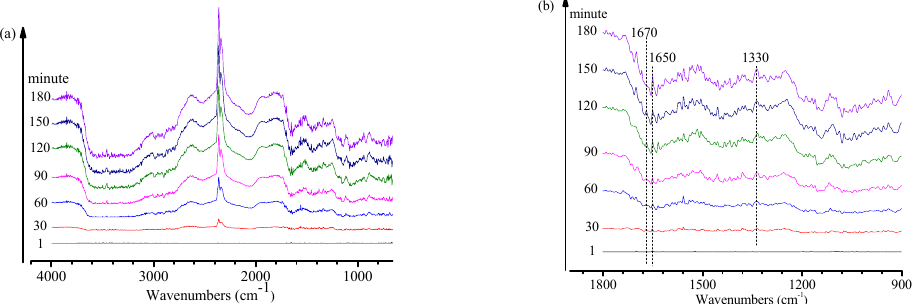
Figure 10. In situ IR spectra of formaldehyde adsorption: ( a ) full spectra and ( b ) partial enlarged drawing.